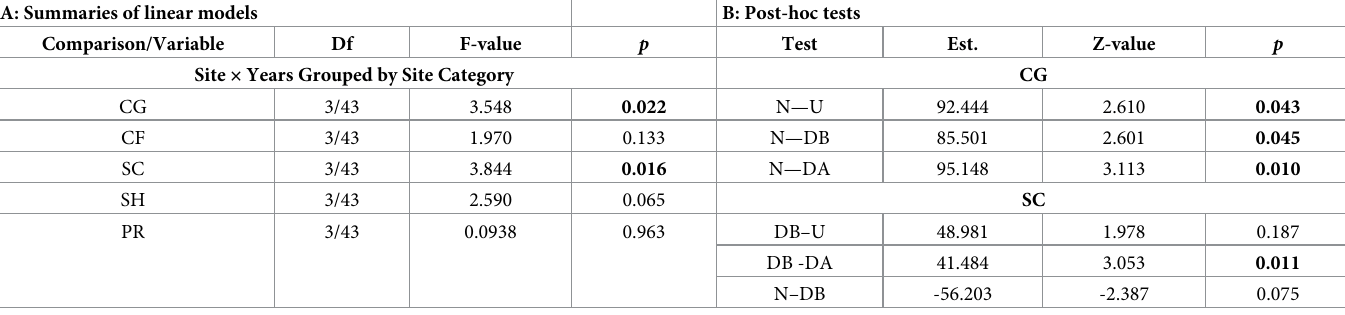
Table 3. A) ANOVA tables of linear models for five functional feeding groups (FFG) according to Bouchard (2004) as predicted by different site categorizations. B) Post hoc tests for differences in site category comparisons for significant FFG groups (CG and